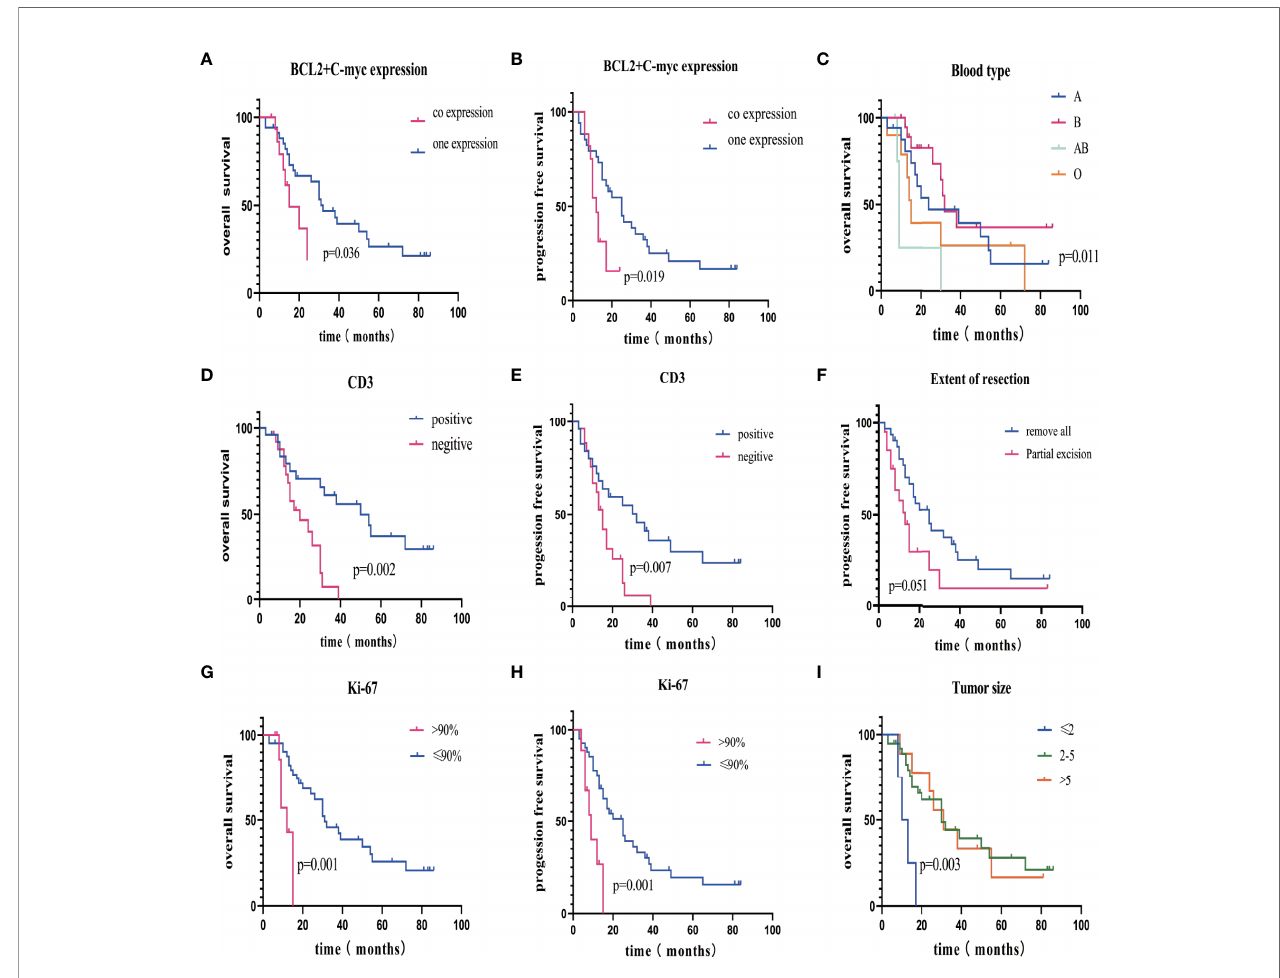
FIGURE 3 | Kaplan – Meier overall survival curve strati fi ed by various risk factors. (A) OS in patients with BCL-2 and C-myc coexpression (red line) or one expression (blue line). (B) PFS in patients with positive C-myc combined with positive Bcl-2 (red line) or the other conditions (blue line). (C) OS in patients with different blood types, there was a signi fi cant difference in OS between different blood types. (D, E) OS/PFS in patients with positive CD3 (red line) or negative CD3(blue line). (F) PFS in patients with GTR (red line) and PR (blue line). (G, H) OS/PFS in patients with Ki-67 >90% (red line) or Ki-67 <90% (blue line). (I) OS in patients with different tumor size. PFS, progression-free survival; OS, overall